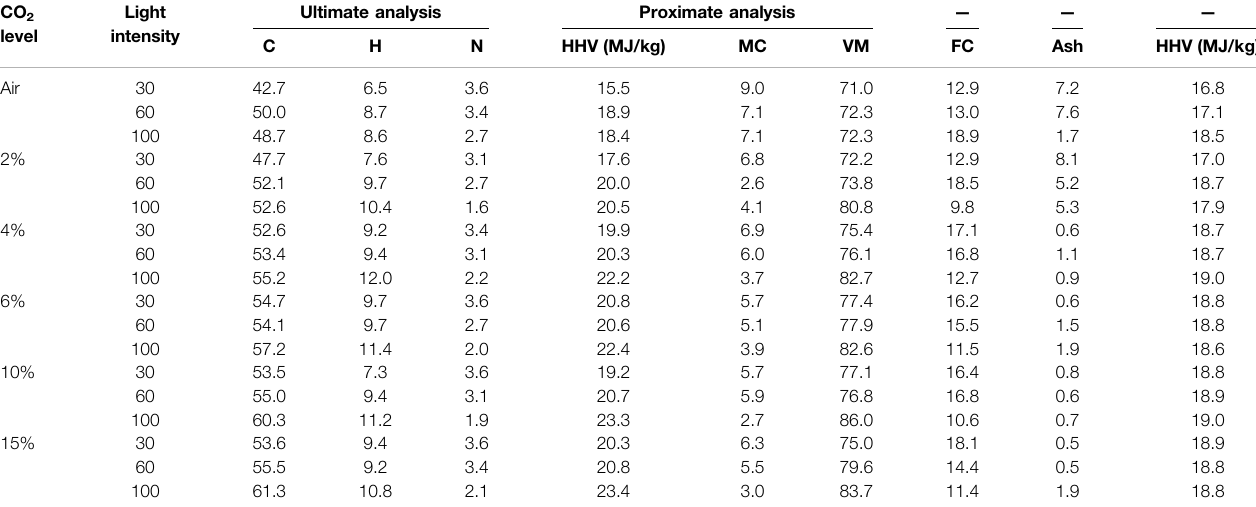
TABLE 2 | Ultimate and proximate analysis of microalgae biomass obtained at different light intensities and CO 2 concentrations. CO 2 Light level